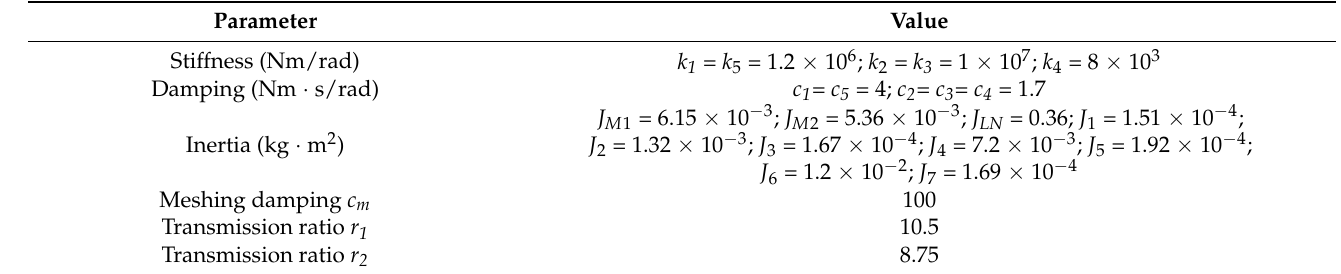
Table 3. Parameters of the mechanical